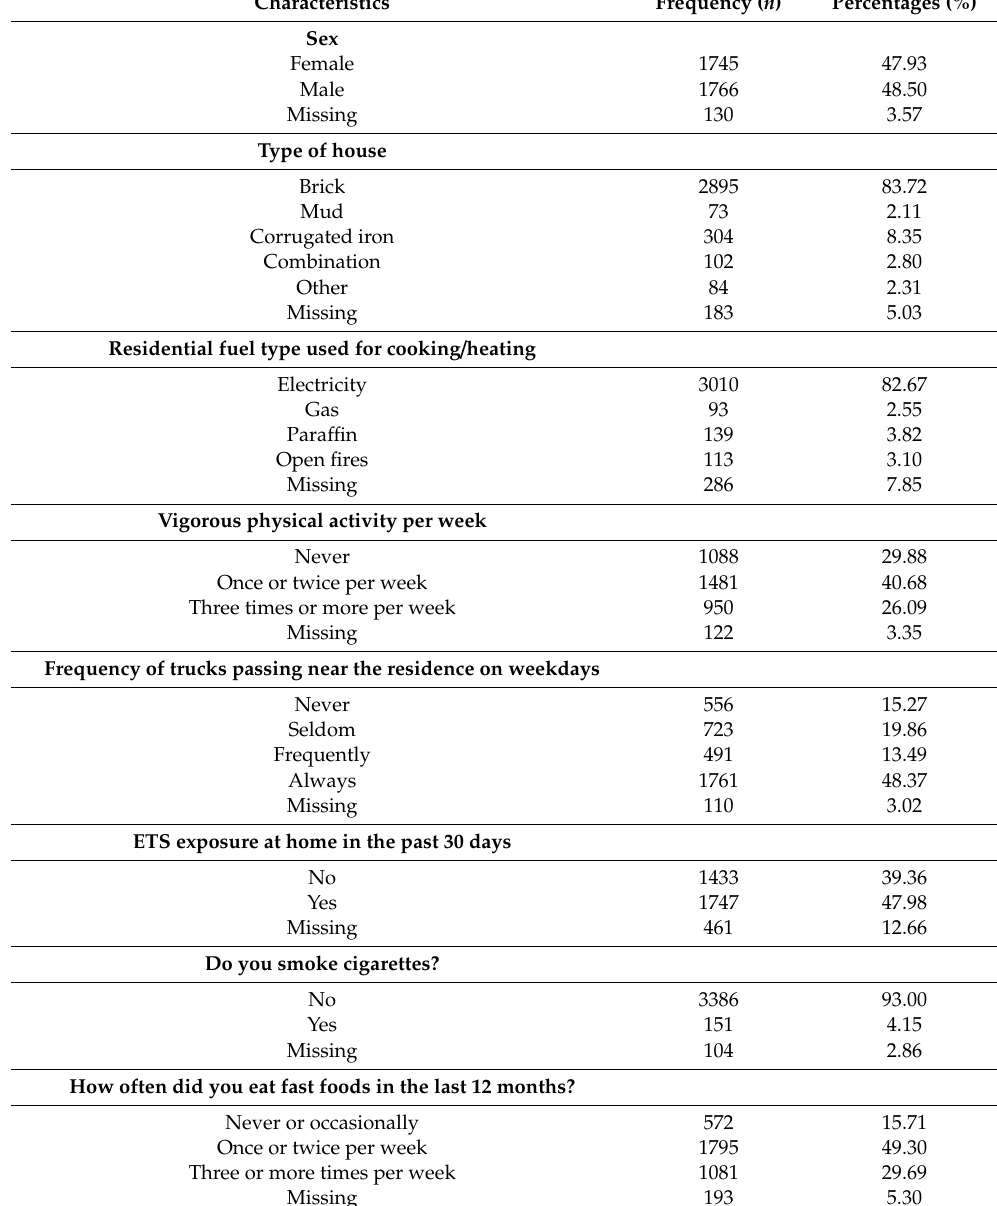
Table 1. Demographic characteristics of the study participants ( n =